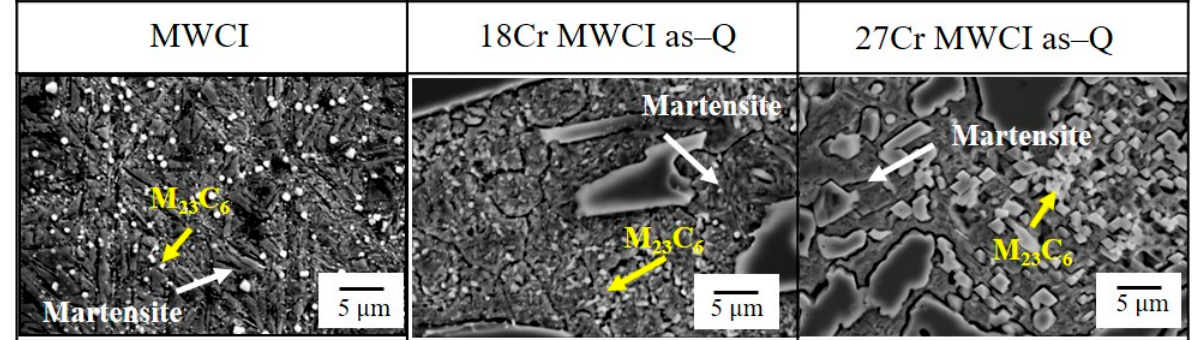
Figure 5. SEM and EDS mapping of representative materials.